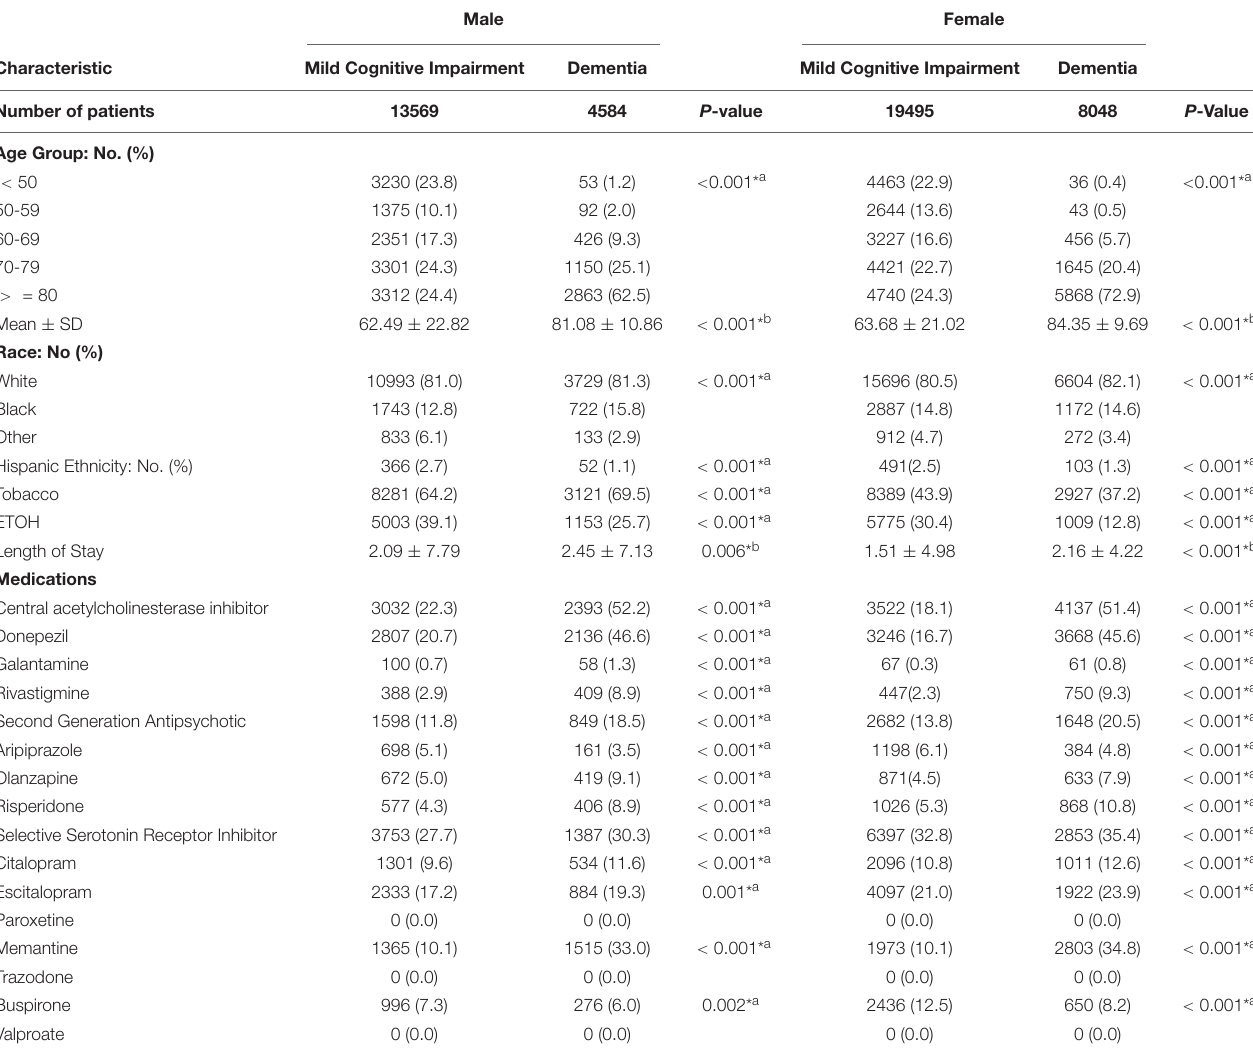
TABLE 2 | Demographic and clinical characteristics of mild cognitive impairment versus dementia in patients stratified by sex. Male